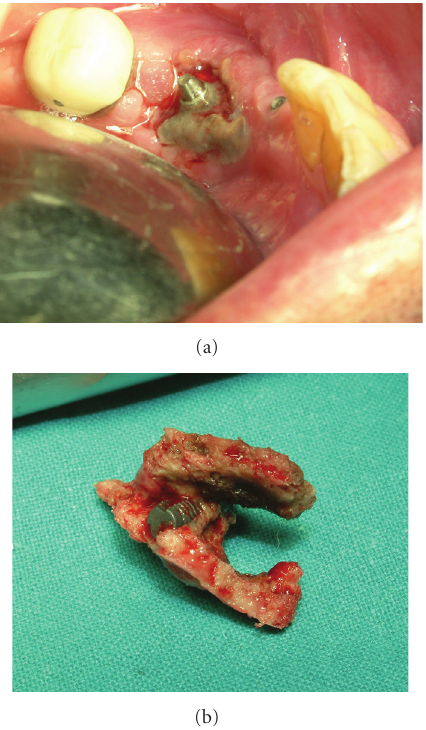
Figure 5: (a) Exposed necrotic bone around the left implant after three months of antibiotherapy. (b) Image of the resected specimen of bone sequestrum including left